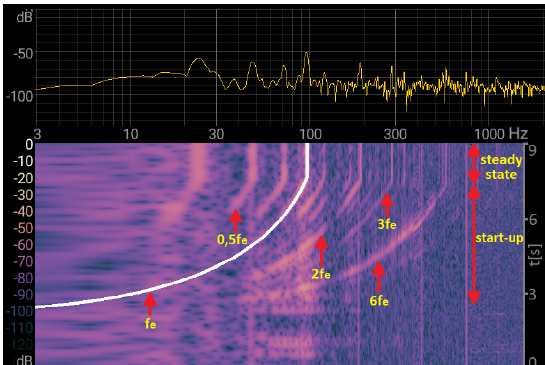
Figure 23. Sound spectrogram measured during start-up ( ω e from 0 to 600 rad applied. Speed ramp 300 rpm